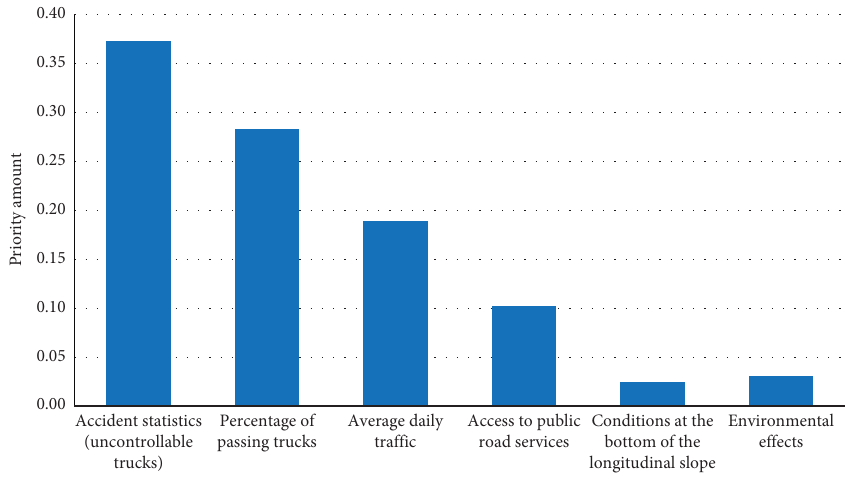
Figure 8: Display of prioritizing subcriteria of other factors. Table 11: Final priority of research subcriteria.